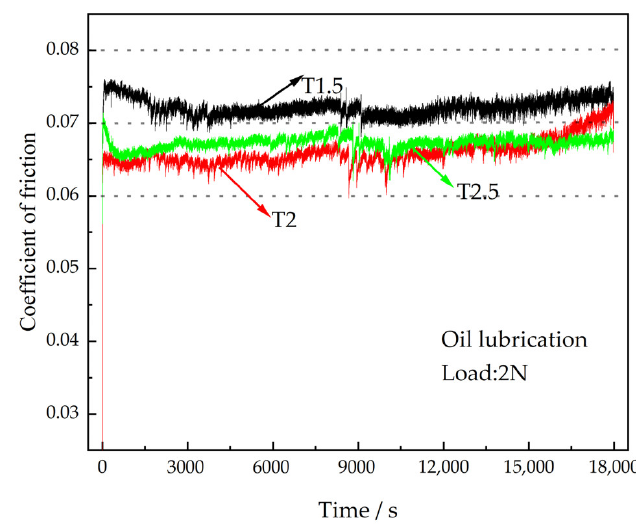
Figure 6. CoFs of the coatings under oil lubrication.